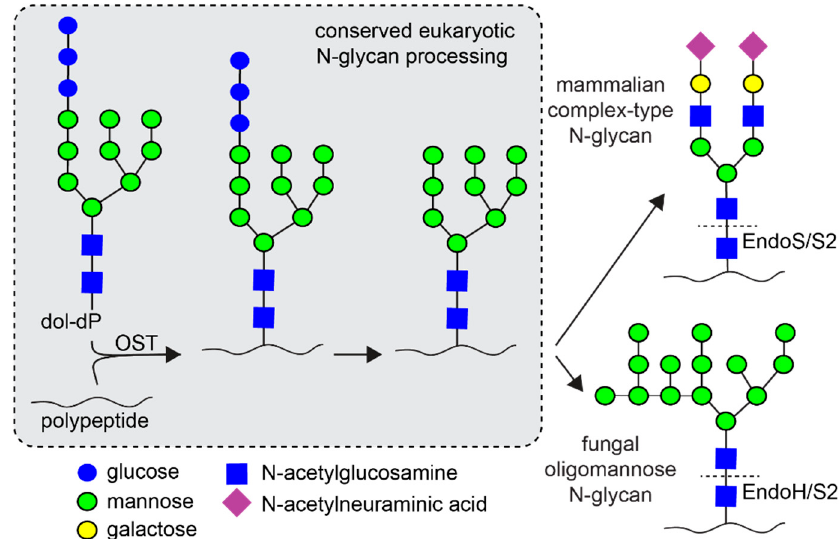
Figure 1. N- glycan processing in yeasts and mammals shares a common starting point. However, the end products are substantially different with yeasts capable of extensive mannosylation. The dashed line indicates the site of endoglycosidase (endo) cleavage; EndoS and EndoS2 cleave IgG1 N- glycans. OST—oligosaccharyltransferase; dol-dP—dolichol diphosphate.